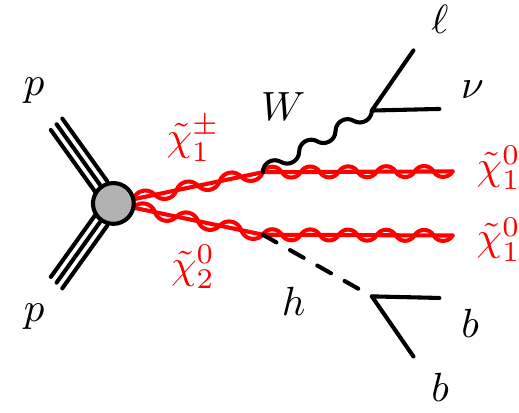
Fig. 1 A diagram illustrating the signal scenario considered for the production of a chargino and a next-to-lightest neutralino